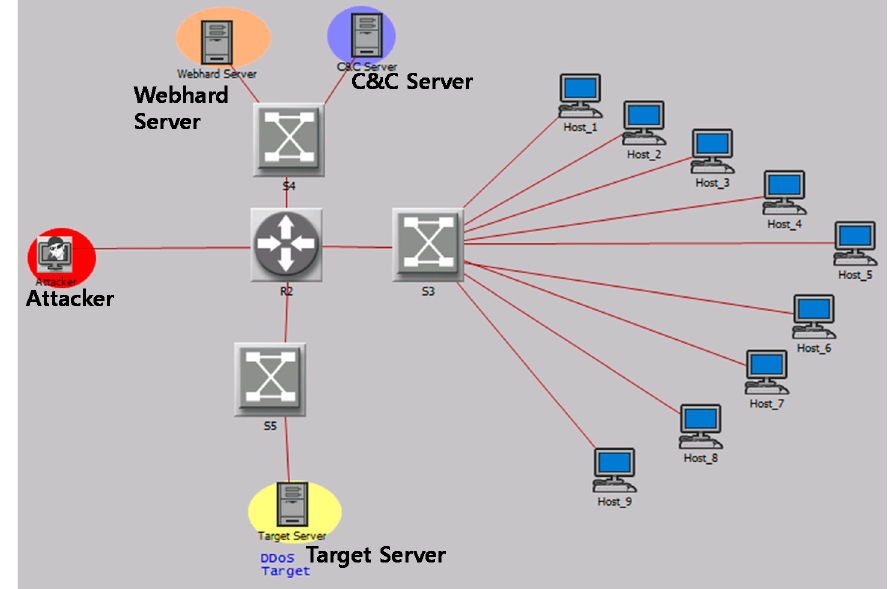
Figure 12. Hierarchical multi-stage scenario-based network based on proposed analysis system.